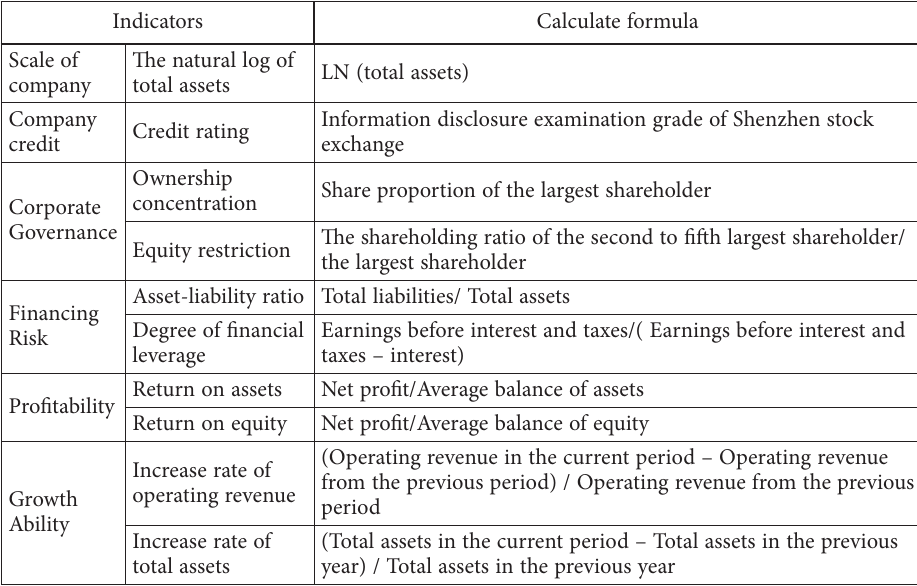
Table 2. Evaluation index system of internal financing ecology Indicators